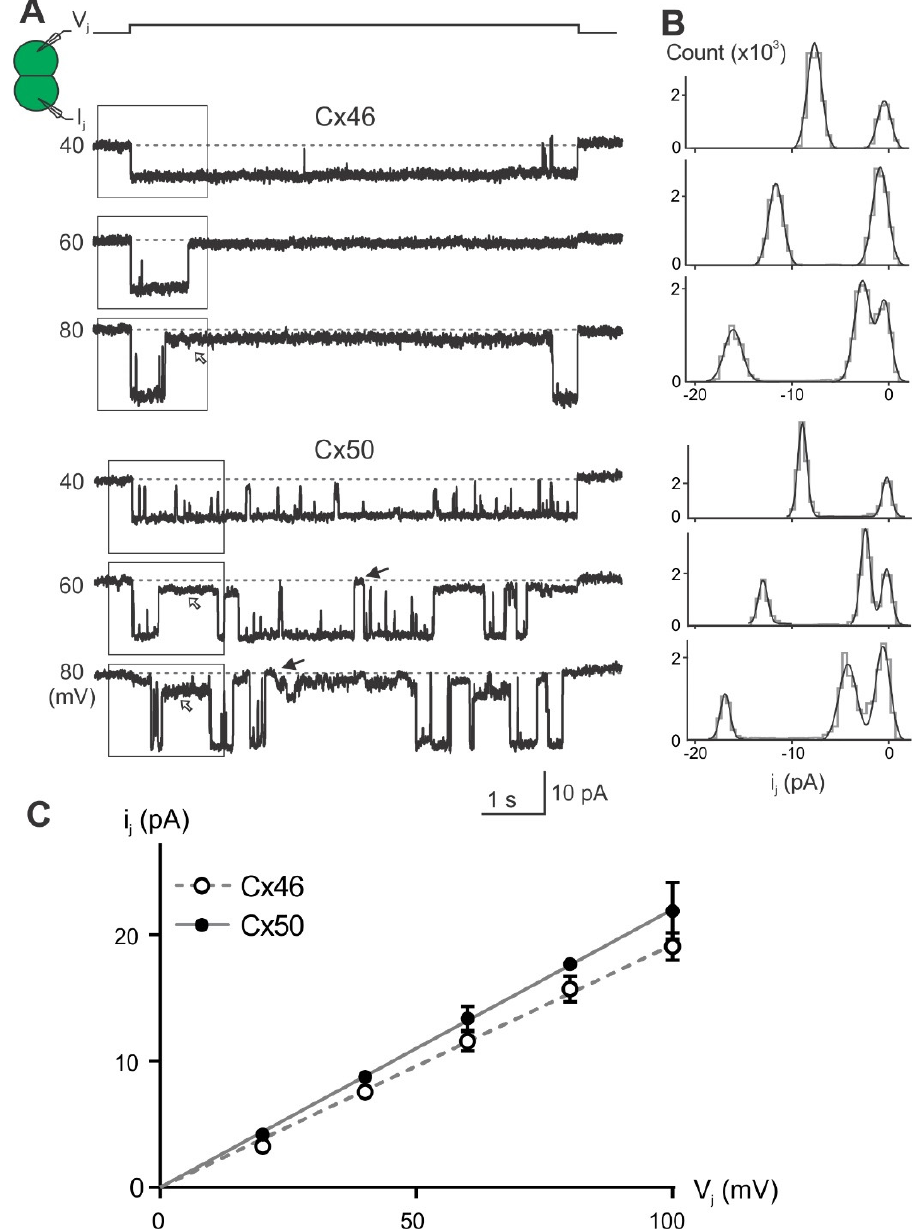
Figure 6. Unitary channel properties for wild-type Cx46 and Cx50 GJs. ( A ) Single channel currents (i j s) recorded as a response to the administration of positive V j pulses (+V j ) as indicated. After the channels are fully open, they enter either a subconductance state (open arrows) or a fully closed state (solid arrows). Boxed areas represent the region used to create the corresponding all-point histograms shown on the right for each V j . ( B ) All-point histogram (grey lines) and Gaussian fits (smooth black lines) for i j s of Cx46 and Cx50 at 40, 60, and 80 mV V j pulses, showing the i j amplitude at the main open state and fully closed state. Subconductance states were also identified at some V j s. ( C ) Scatter plot of i j s amplitude at the main open state for the entire tested range of V j s. Linear regression of each i j –V j plot was used to obtain the slope, which represents slope unitary channel conductance ( γ j ) for Cx46 or Cx50.